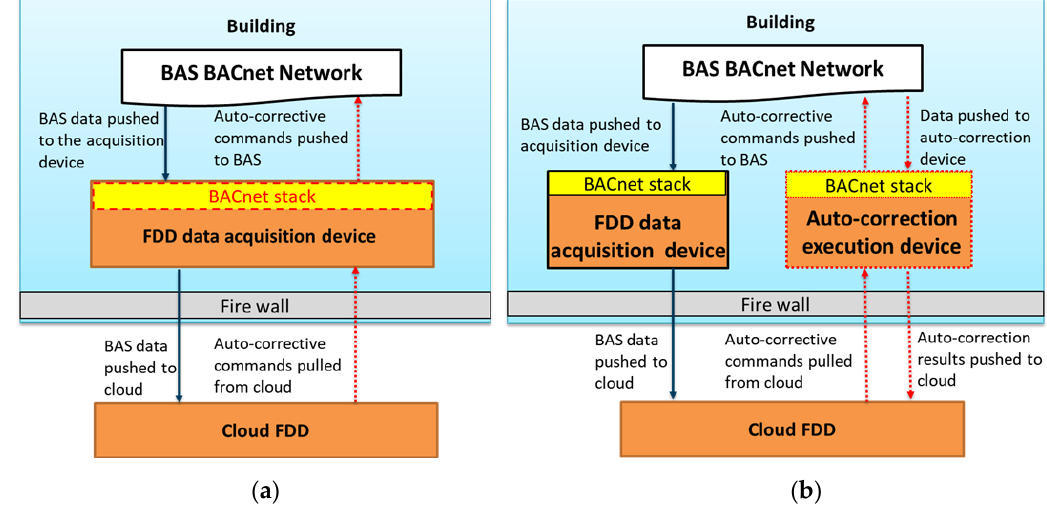
Figure 9. Two-way communication infrastructure for ( a ) the cloud-based FDD system 1, and ( b ) the cloud-based FDD system 2.